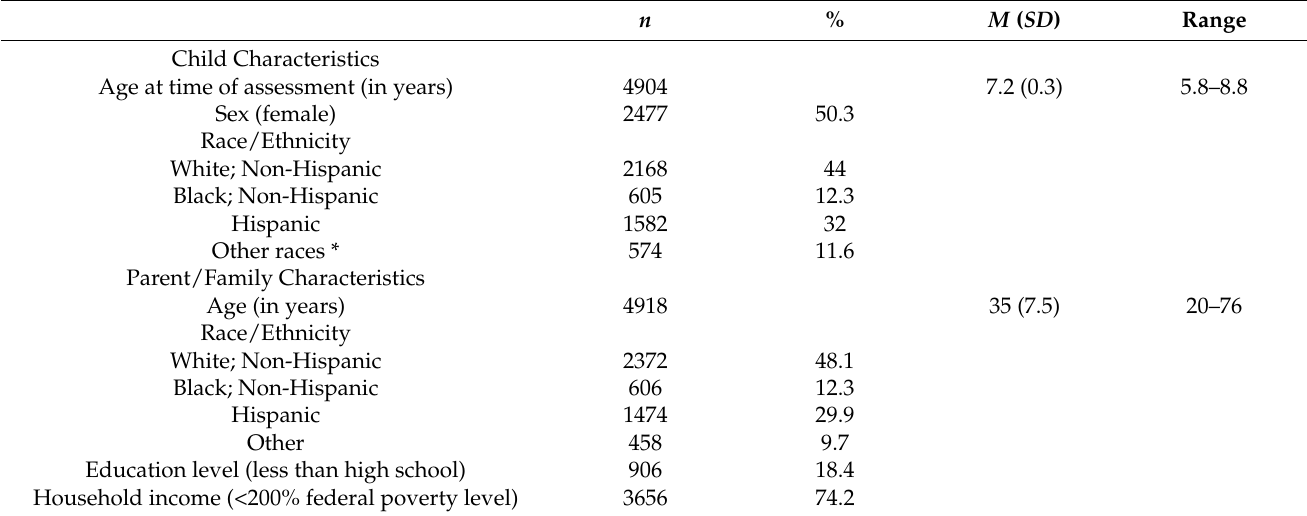
Table 1. Sample Characteristics ( n =